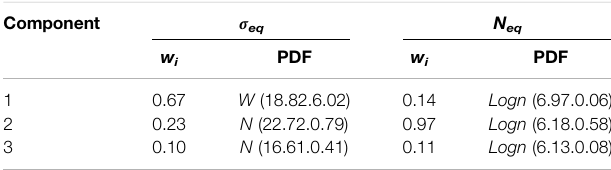
TABLE 1 | The statistical model of equivalent fatigue loading effects in the downstream side. Component